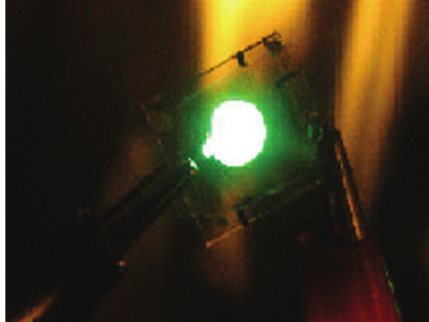
Figure 20: Cellulose Nanocomposite based Flexible Organic Light Emitting Diode